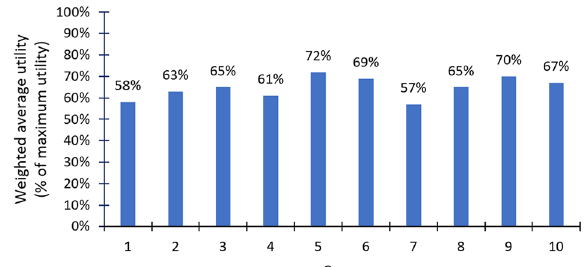
Fig. 5 Average utility weighted by probability of absorption and normalized by maximum